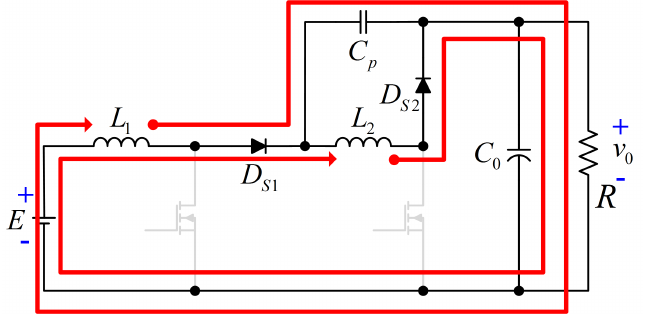
Figure 6. Circuit for the interval t OFF .